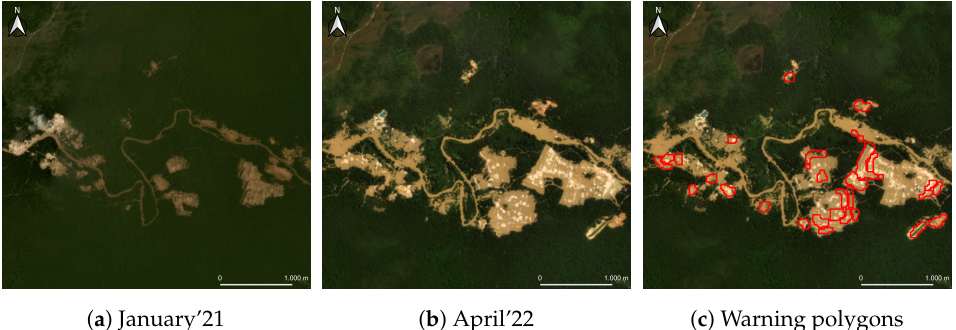
Figure 11. Example of deforestation warnings issued by the DETER-R system inside the Kayapó Indigenous Territory, in the state of Pará. Clearings are caused by illegal sand and gold mining. Notice the small features not captured by the detection algorithm due to the Minimum Mapping Area constraint. Satellite background true-color image by Planet Labs Inc.